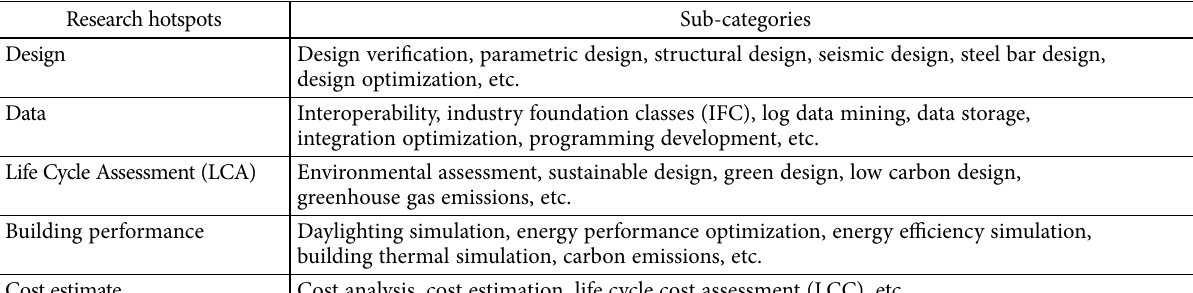
Figure 7. Number of articles at each stage of the life cycle from 2011 to 2020 Table 5. Main research focus at the design